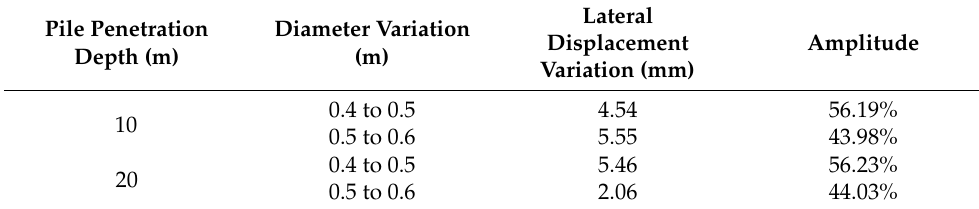
Figure 17. Influence of the diameter of the new pile on the bending moment of the used pile.